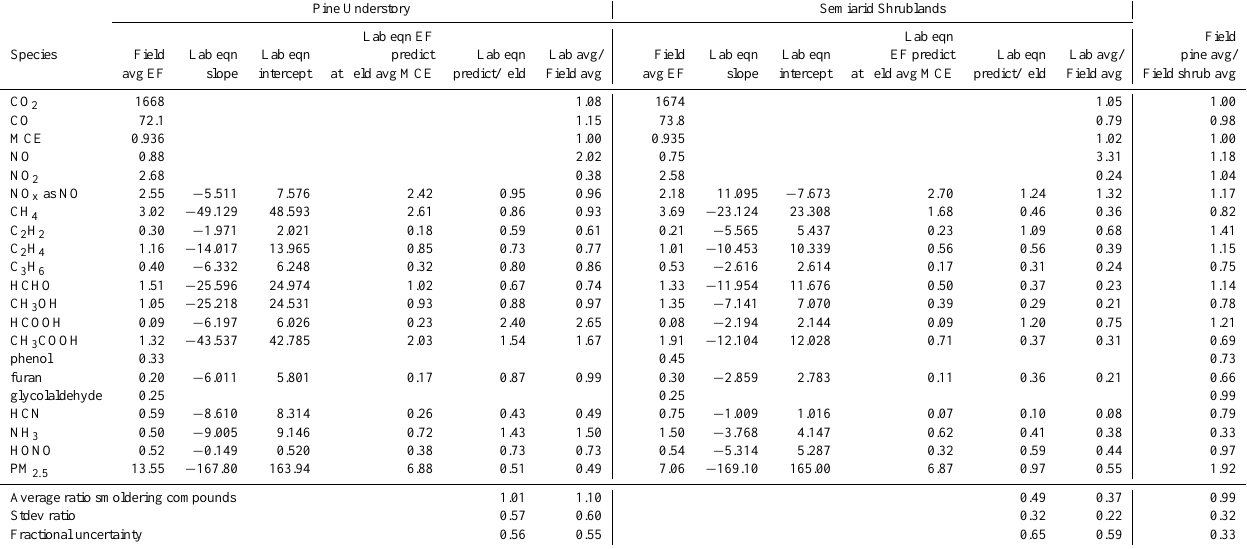
Table 1. Summary of the comparison of emission factors measured in the lab and field and between different ecosystems in the field. Pine Understory Semiarid Shrublands Lab eqn EF Lab eqn Field Species Field Lab eqn Lab eqn predict Lab eqn Lab avg/ Field Lab eqn Lab eqn EF predict Lab eqn Lab